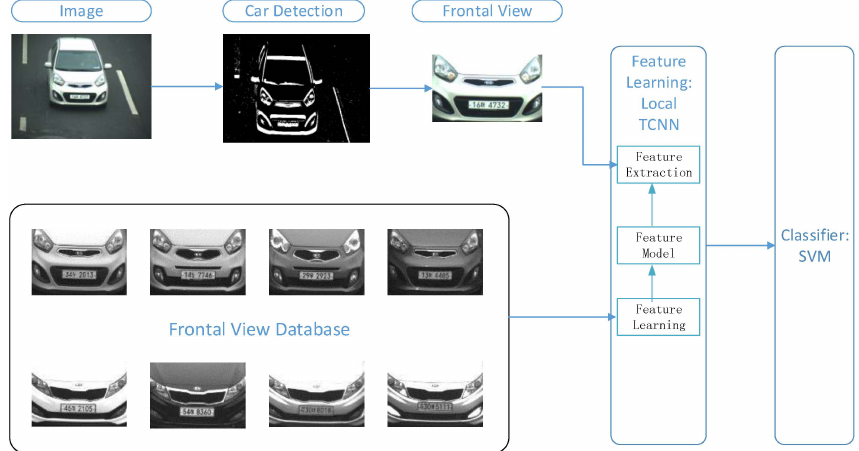
Figure 3. Framework of proposed vehicle make and model recognition (MMR) system based on LTCNN. Moving vehicle was detected using the frame difference, and the resultant binary image was used to detect the frontal view of a vehicle with a symmetry filter. The detected frontal view was used to identify the vehicle make based on the LTCNN